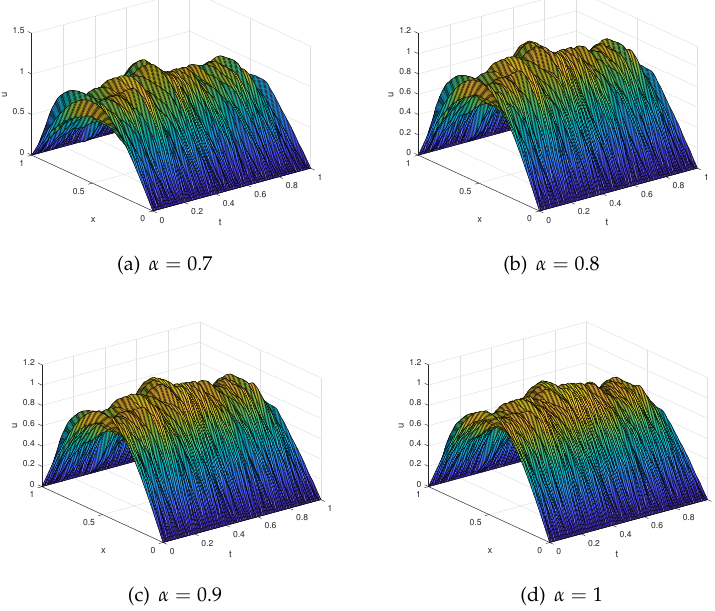
Figure 2. The approximation solutions of Example 1 with σ =